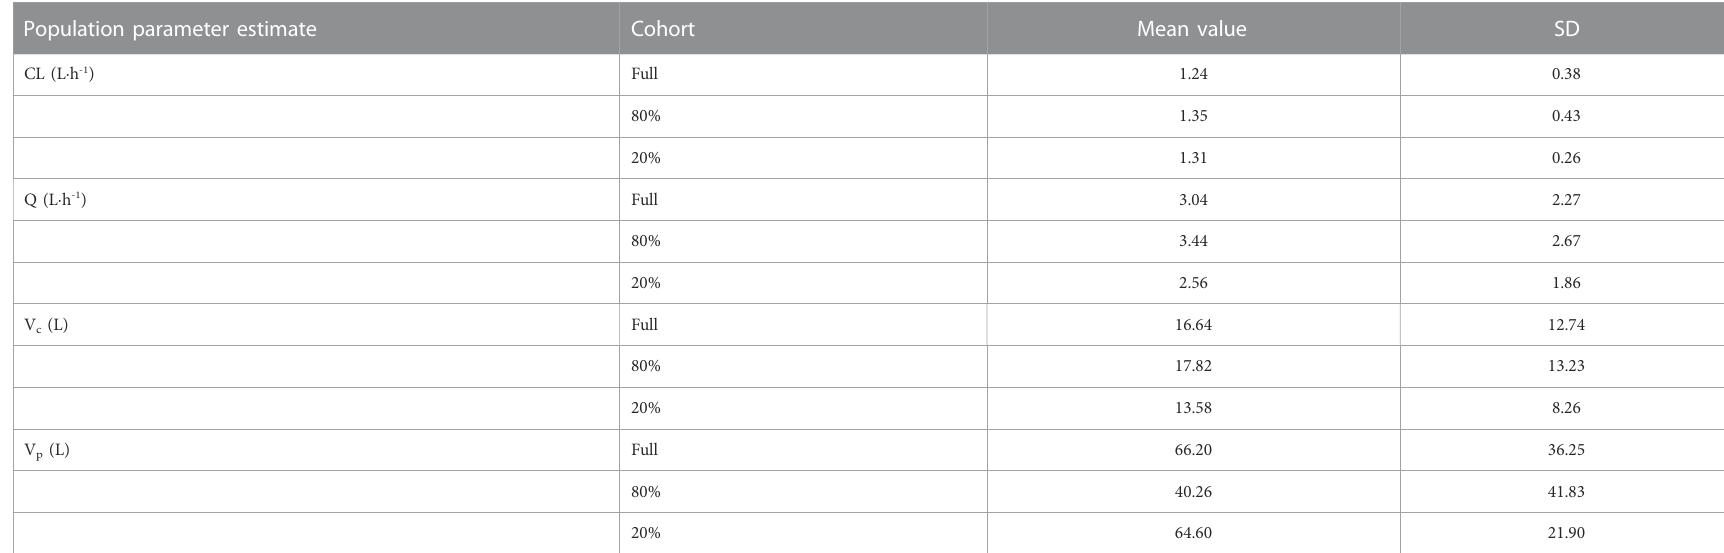
TABLE 4 PPK parameter estimates and precisions of estimates (SD) for the full data set, 80% of the data, and 20% of the data. Population parameter